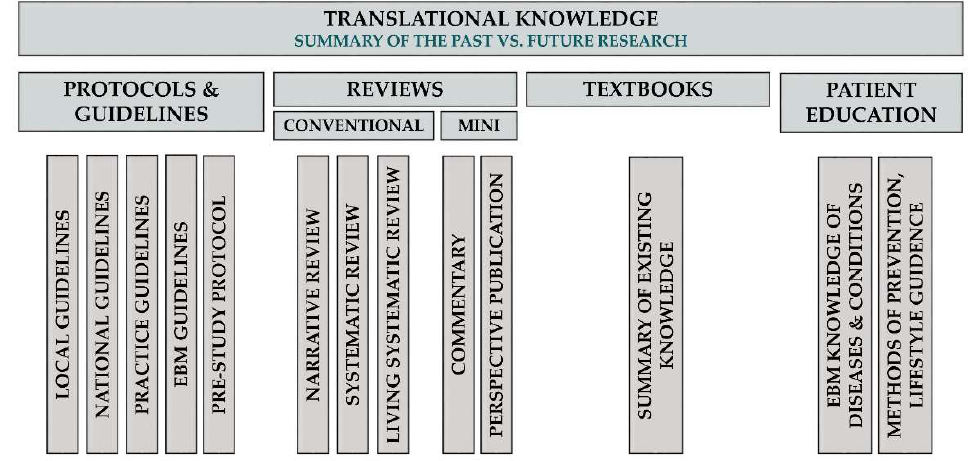
Figure 5. Translational